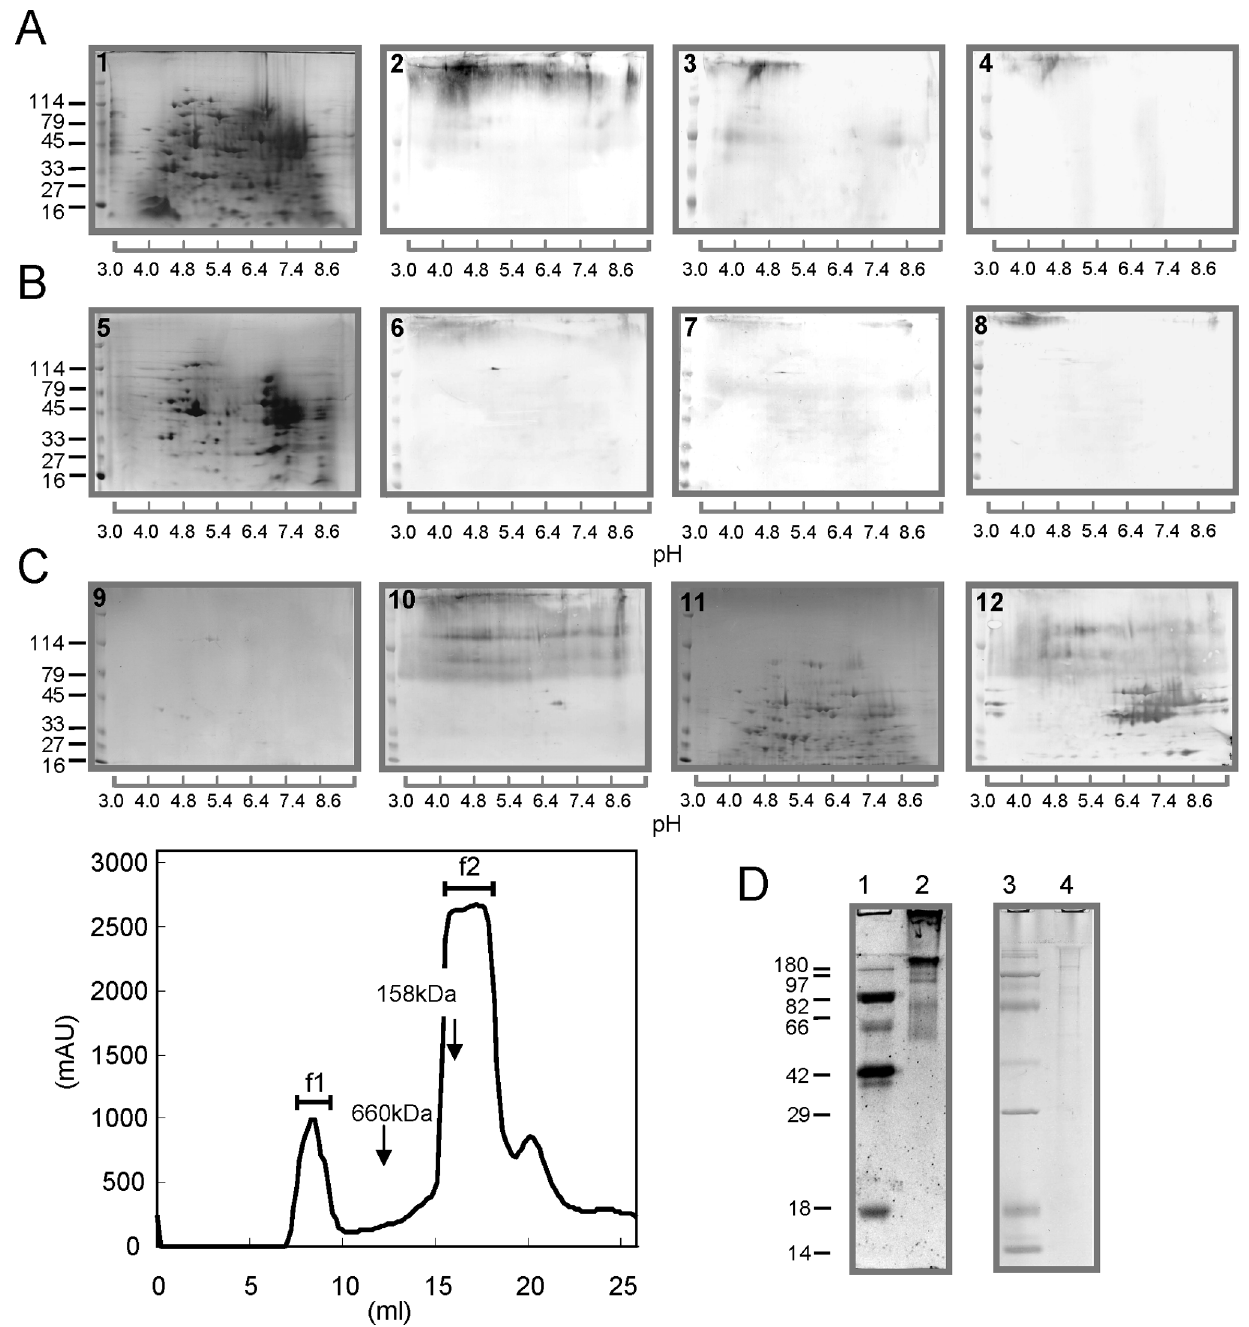
Figure 1. Identification and purification of vaccine antigen (SRf1) from E.multilocularis . Crude extracts were prepared from protoscoleces (PCE) and adult worms (ACE). A total of 120 m g protein was applied to 2D-PAGE. The proteins were blotted onto a PVDF membrane, and reactivity between proteins and intestinal IgA from dogs experimentally infected with E. multilocularis was examined. Panels A and B: PCE and ACE, respectively; panels 1 and 5: CBB-stained gels; panels 2 and 6: tested with intestinal IgA from dogs infected 5 times; panels 3 and 7: tested with intestinal IgA from dogs infected 3 times; and panels 4 and 8: tested with intestinal IgA from dogs infected once. Molecular size markers are indicated on the left (in kDa). Panel C: a gel filtration chromatogram of the vaccine antigen (SRf1) and 2D-western blot analysis; panels 9 and 11: CBB-stained gels of SRf1 and SRf2; panel 10: 2D-western blotting for SRf1 using intestinal swabs from dogs infected 5 times; panel 12: 2D-western blotting for SRf2 using sera from dogs infected 5 times. Panel D: SDS-PAGE analysis of SRf1; lanes 1 and 2: glycoprotein stained-gel of molecular size markers and SRf1; 3 and 4: CBB-stained gel with molecular size markers and SRf1. Glycoprotein detection was performed with a Pro-Q Emerald 300 gel stain kit and CandyCane glycoprotein molecular weight standards.